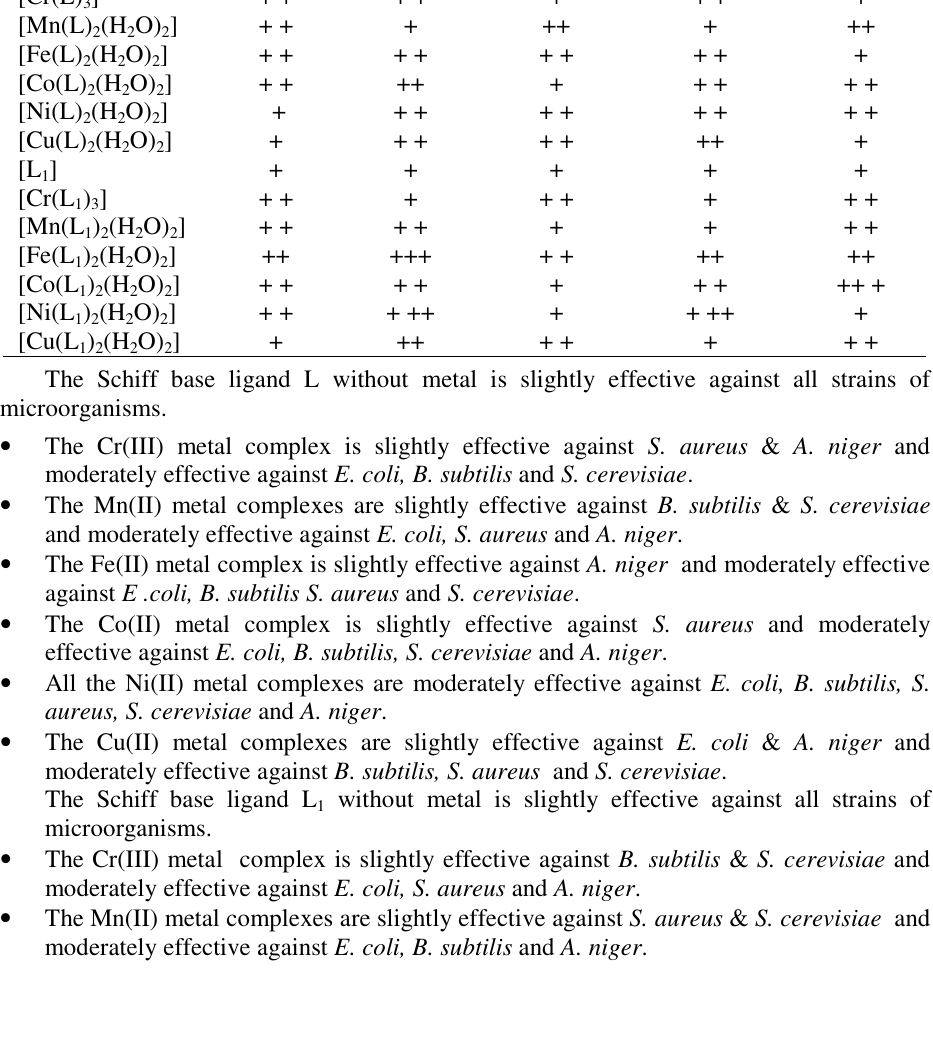
and their metal complexes 1